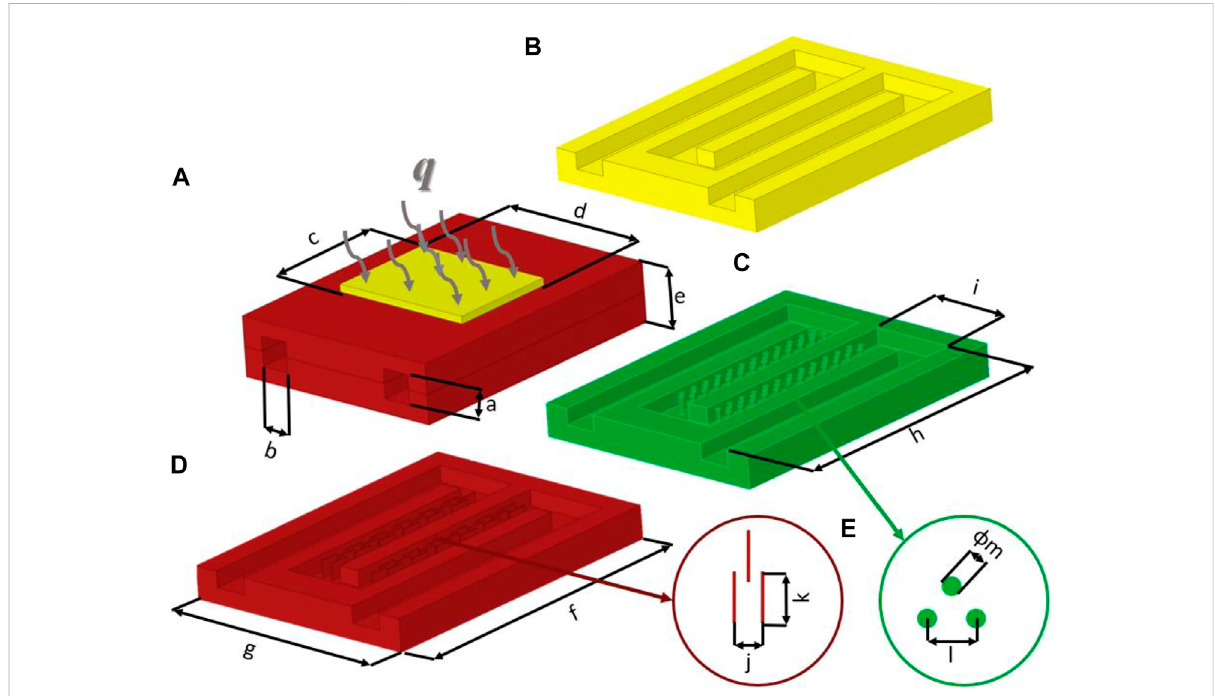
FIGURE 1 (A) Coldplatesizeparameterdiagram (B) Normalcoldplatestructure (C) Coldplatestructurewithsticks (D) Coldplatestructurewith fi ns (E) Fin size parameter.